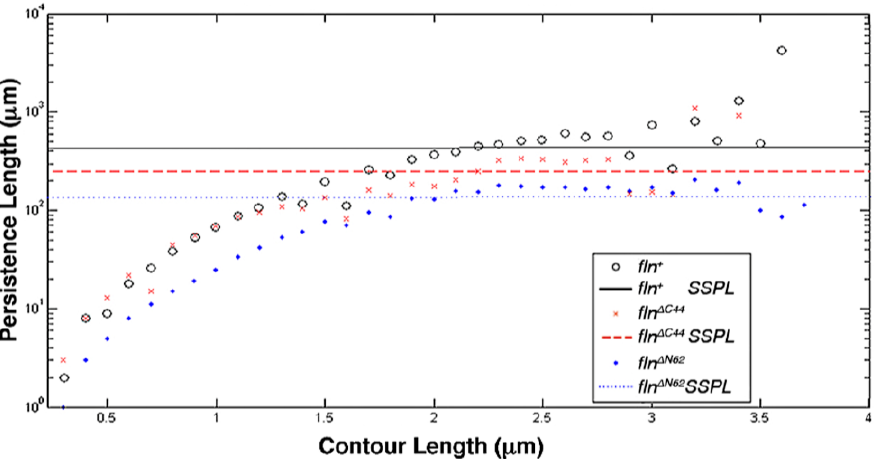
Figure 4. Persistence Lengths and Steady state persistence lengths (SSPL) were calculated for thick filaments from each population by determining the “per filament persistence length”, or specific persistence length (SPL), at each contour length. SPL values for filaments equilibrated onto 2-dimensional substrate were obtained according to Equation (1), and were then averaged at each 100 nm interval contour length. Horizontal lines indicate the line of best fit for persistence length at contours greater than 1.2 μm.